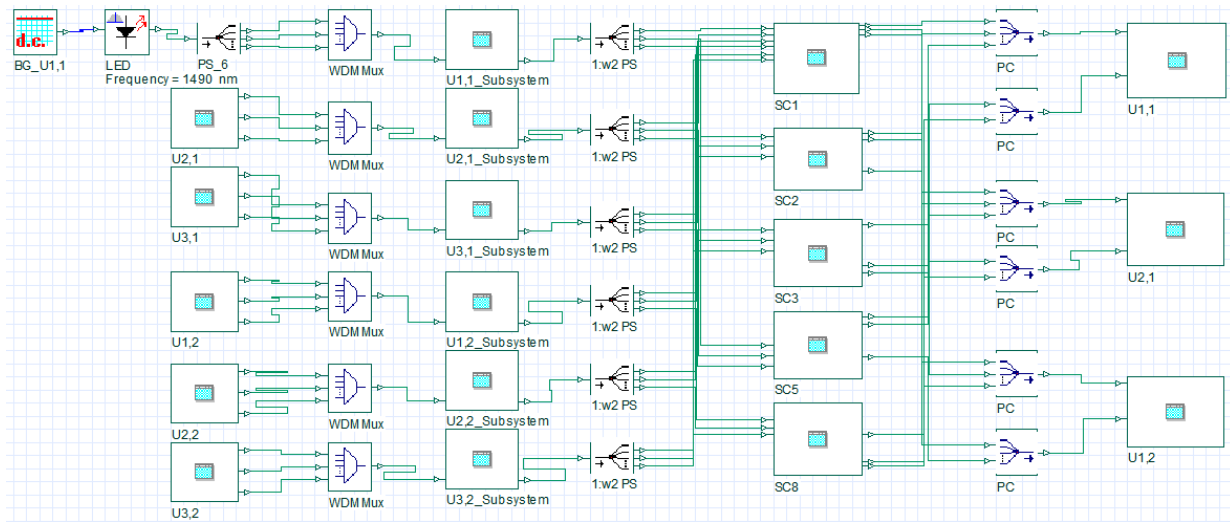
Figure 7. Simulation model of 2D-BIBD code for six users at 1 Gbps and − 10 dBm input power. The balanced detector is essentially made from the combination of uniform FBG filters with a bandwidth of 0.4 nm to recover the signal with maximum auto and zero cross-correlation at the receiving